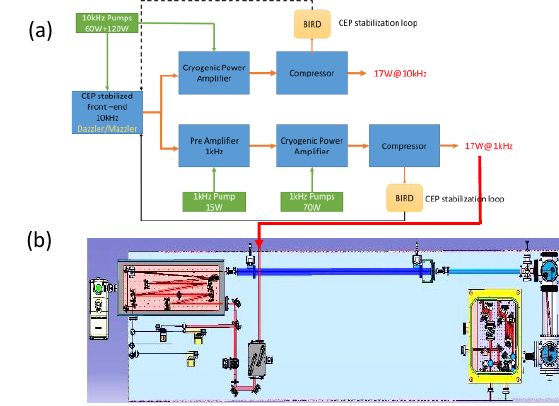
Fig 1. (a) General layout of CEP-stabilized, sub-20 fs, 1 kHz/10 kHz DUAL laser system. (b) 3D drawing of the HCF set-up with energy attenuator, coupling chamber including chirped mirrors and focusing astigmatism free telescope (in pink), output chamber with collimating telescope coupled to chirped mirror and wedges compressor (in